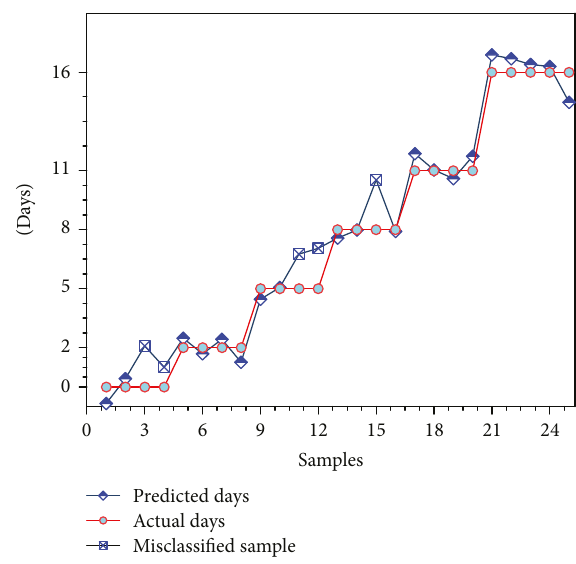
Figure 6: Predicted results of PLSR model for test sets of the salmon meat.